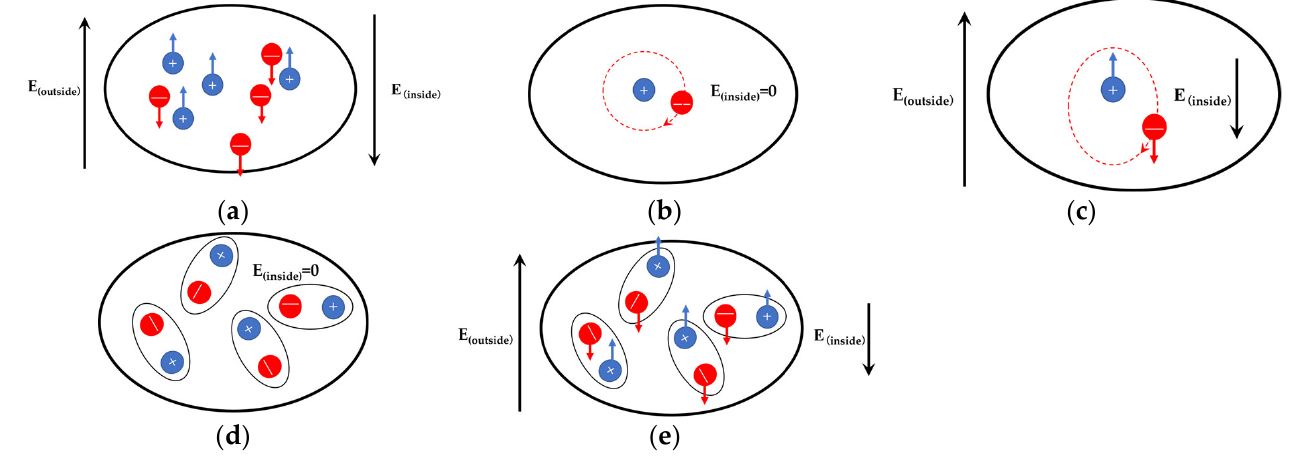
Figure 14. Simulation diagram of charge change in the conductor. ( a ) An external electric field acts on a conductor; ( b ) conductor internal displacement before polarization; ( c ) after internal displacement polarization of the conductor; ( d ) the conductor is oriented before polarization; ( e ) after the conductor is oriented and